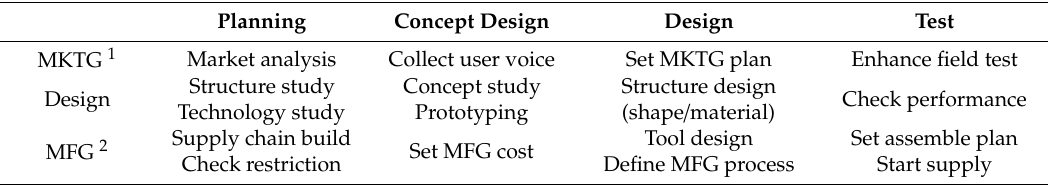
Table 1. Product development process.